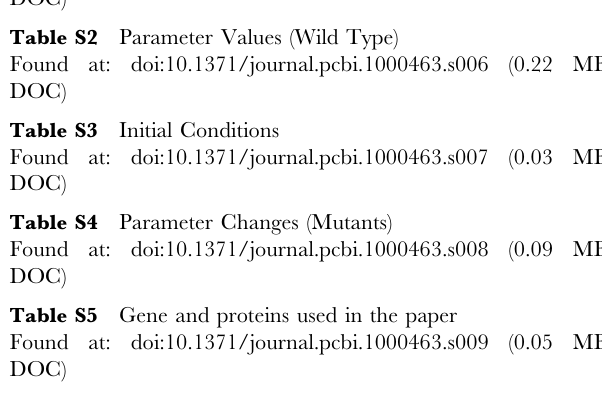
Table S1 Equations of the Model